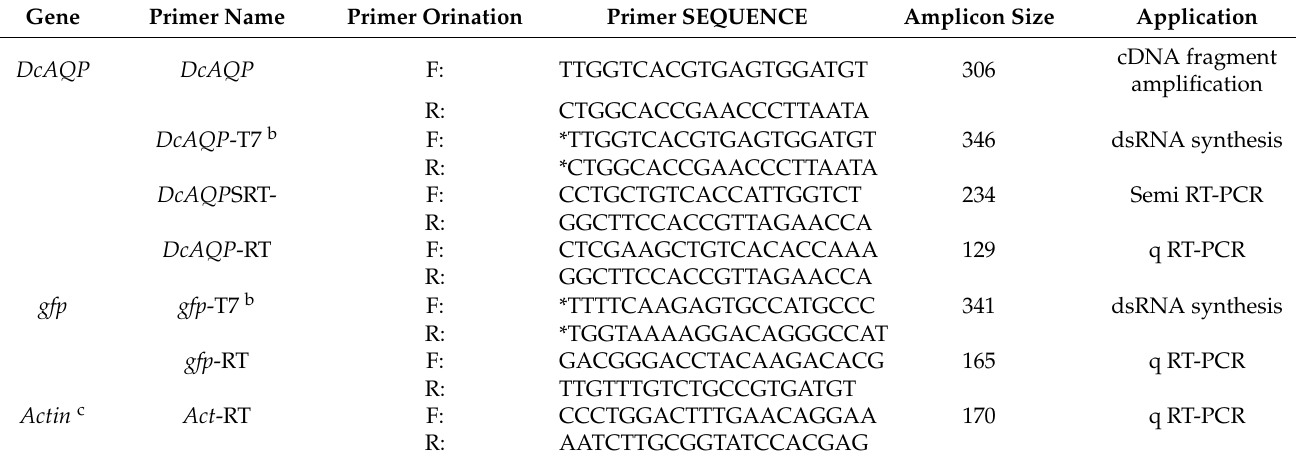
Table 1. Oligonucleotide primer pairs used in the present study a